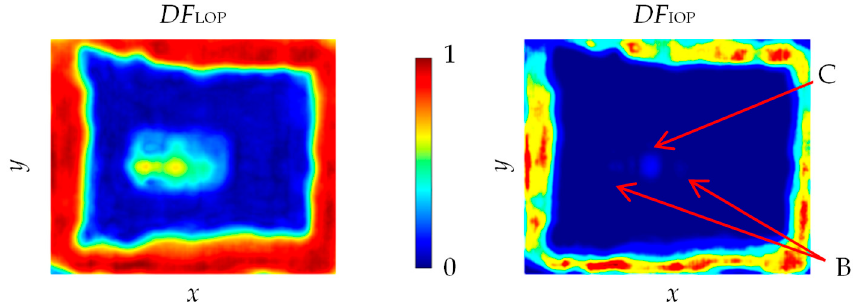
Figure 18. Multi-source data (of IRT , UT G , THz GBS , THz SPR and P MW3 ) integration results under two strategies: linear opinion pooling DF LOP and independent opinion pooling DF IOP ; B—indication of dielectric support; C—indication of glass–support adhesive